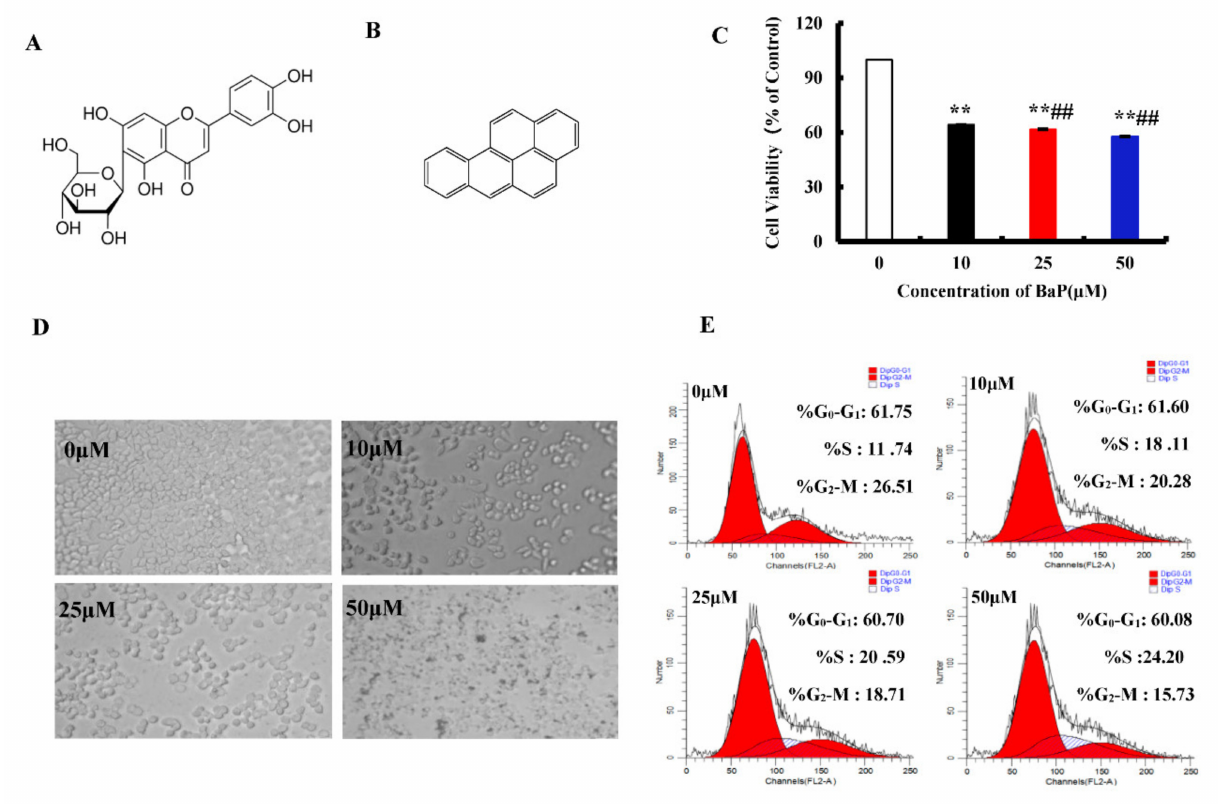
Figure 1. Effects of BaP on the proliferation of HL-7702 cells. Chemical structure of Iso ( A ) and BaP ( B ). Cells were incubated with BaP at different concentrations for 24 h and then processed for MTT assay. ** p < 0.01 compared with control, ## p < 0.01 compared with 10 µ M BaP ( C ). Effect of BaP on cell morphology, which was observed with an optic microscope ( D ). Representative histograms of DNA content and cell cycle phases (G 0 -G 1 , S and G 2 -M) in BaP treated cells ( E